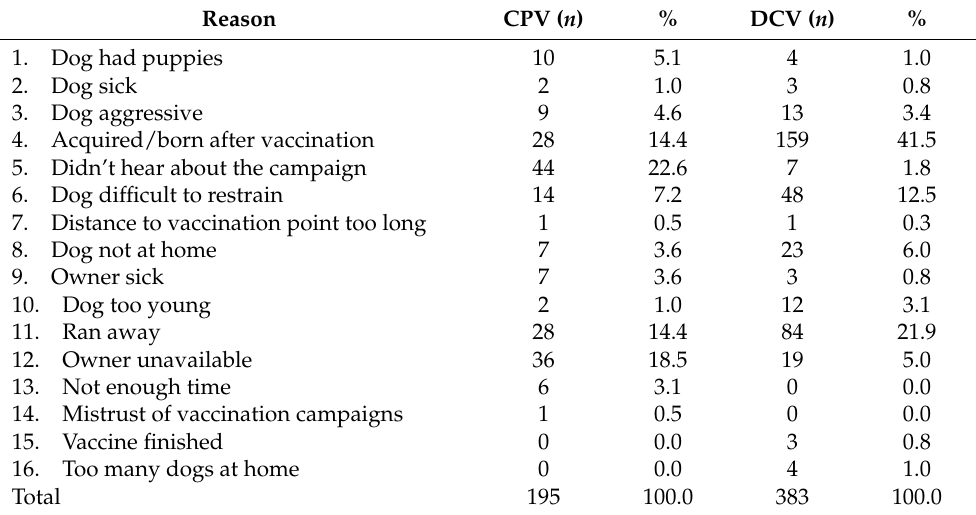
Table 4. Reasons for not vaccinating dogs under centralized pulsed vaccination and decentralized continuous vaccination strategies.